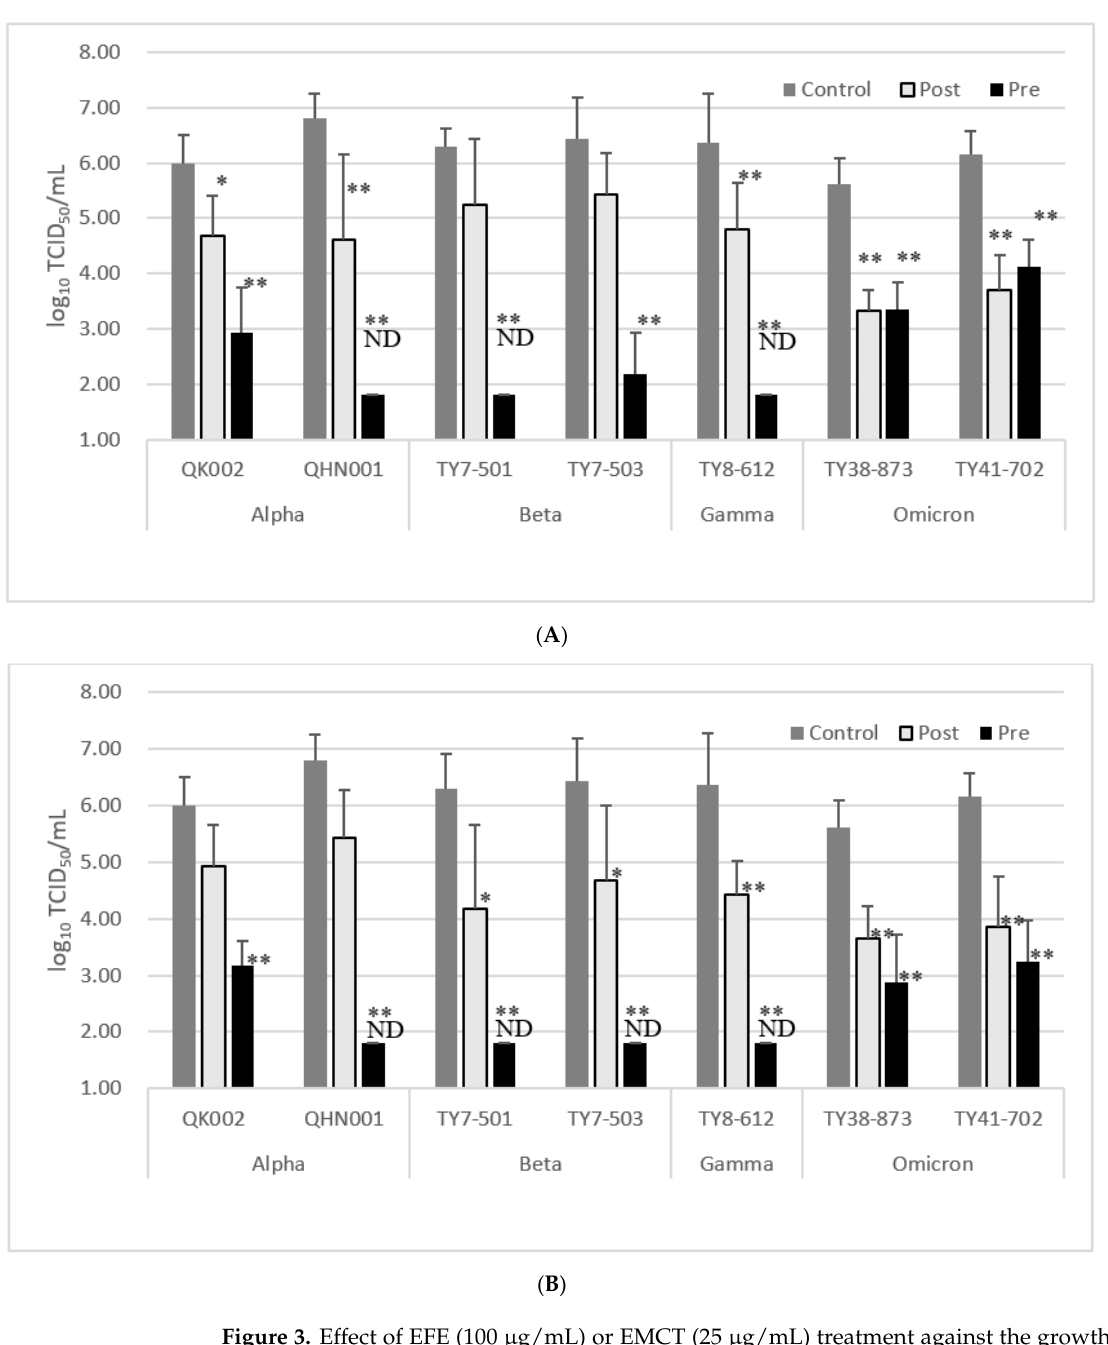
Figure 3. Effect of EFE (100 μ g/mL) or EMCT (25 μ g/mL) treatment against the growth of SARS- CoV-2 variant strains in vitro at 24 h post-infection. Pre; EFE or EMCT was added 2 h before virus inoculation. Post; EFE or EMCT was added 2 h after virus inoculation. Data are presented as mean ± standard deviation. Limit of detection of log 10 TCID 50 /mL is 1.8. ( A ) Effect of EFE treatment against variant strains. ( B ) Effect of EMCT treatment against variant strains. ND, not detected. Significant differences as compared with control (0 μ g/mL) *; p < 0.05. **; p < 0.01. When EFE was added 2 h after infection at a concentration of 100 μ g/mL, the log 10 reductions in QK002 (alpha), QHN001 (alpha), TY7-501 (beta), TY7-503 (beta), TY8-612 (gamma), TY38-873 (omicron BA.1), and TY41-702 (omicron BA.5) virus titers in the cul- ture supernatant at 24 h post-infection were 1.31, 2.19, 1.06, 1.0, 1.56, 2.27, and 2.46, respec- tively (Table 3, Figure 2B). When EMCT was added after infection at a concentration of 25